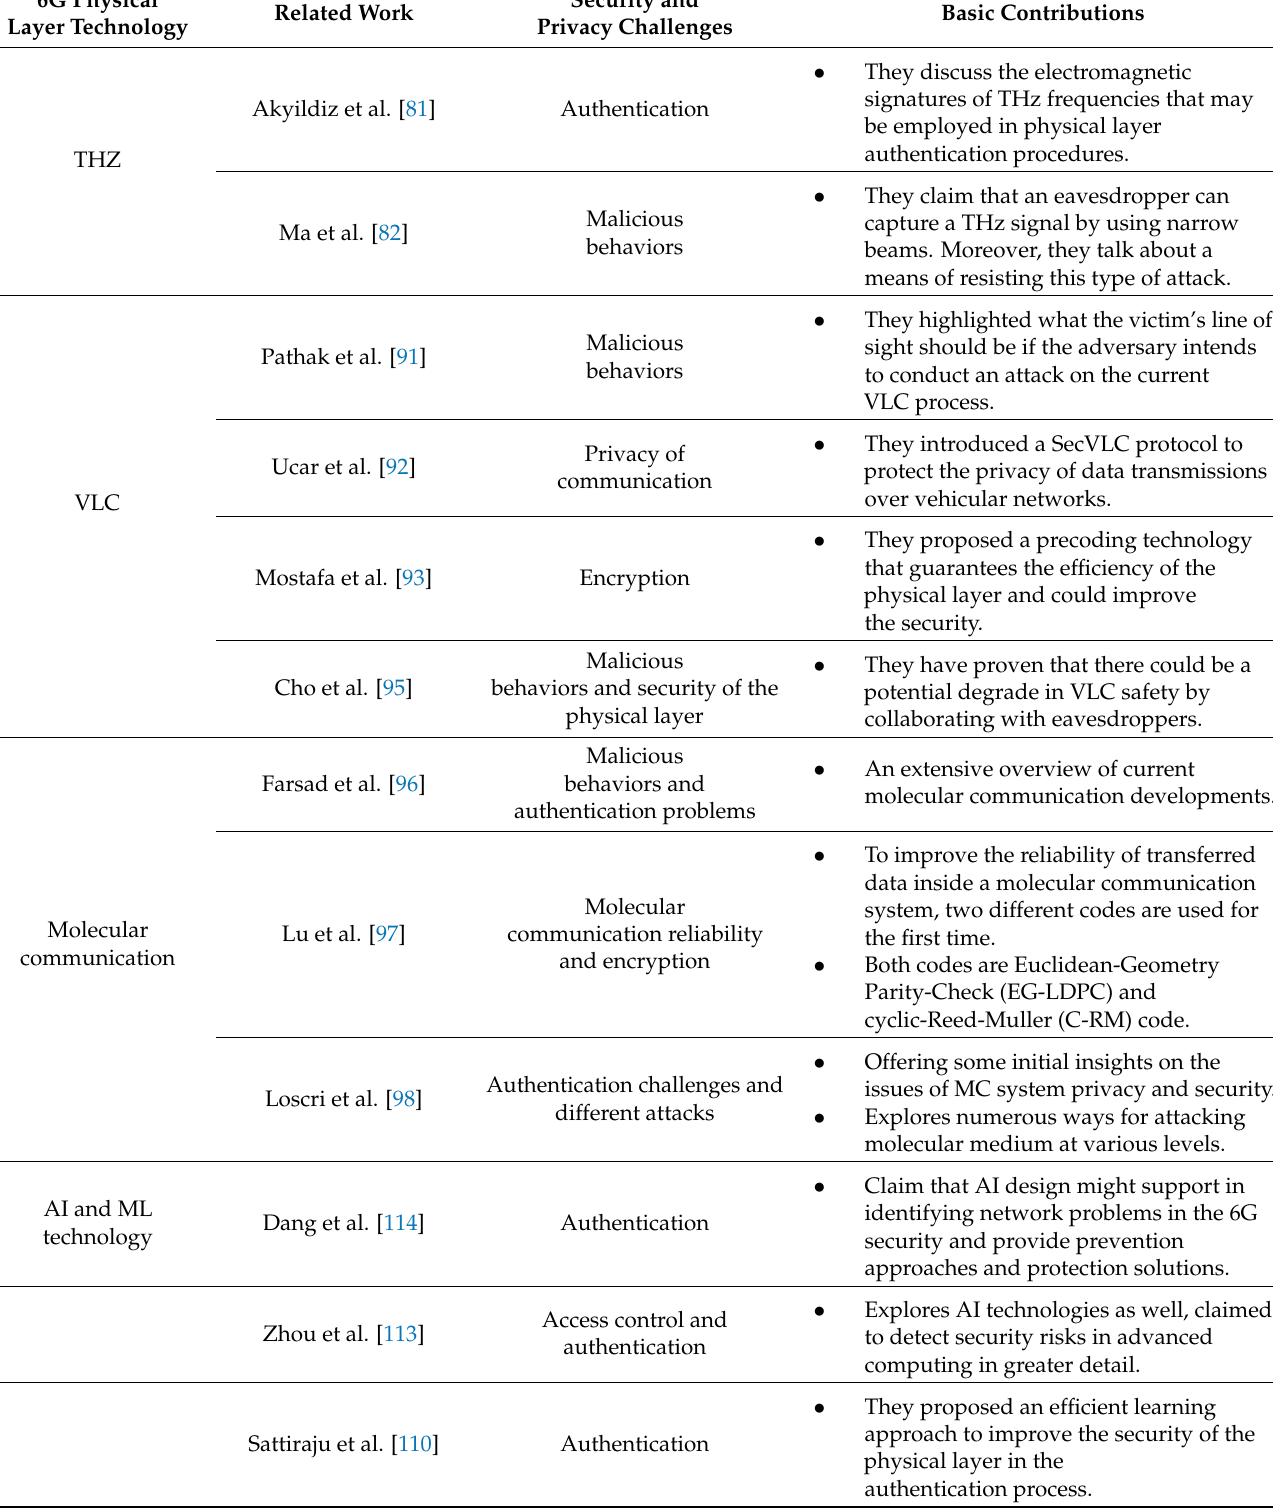
Table 2. The 6G technologies, security challenges, and related work basic